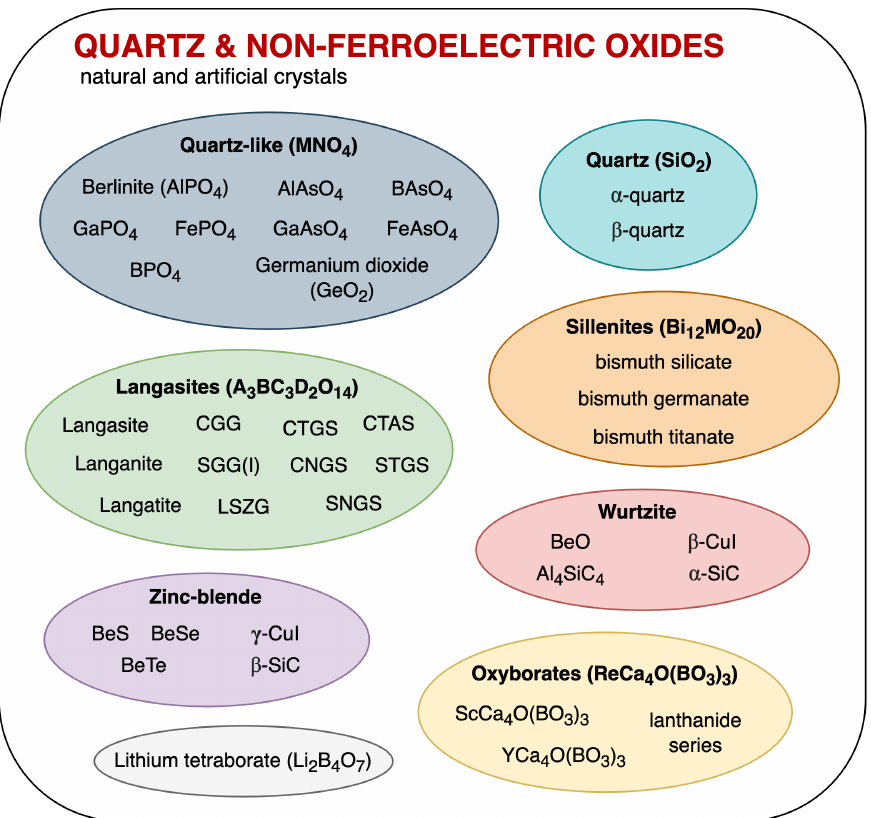
Figure A2. The class of quartz and non-ferroelectric oxides including langasites, sillenites, wurtzites, zinc-blendes and